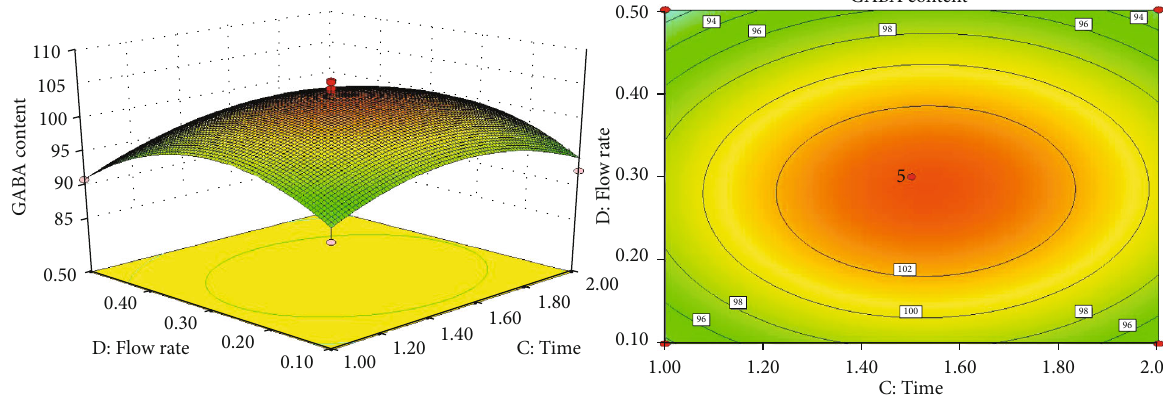
Figure 21: Response surface and contour diagram of time and fl ow rate in fl uence on GABA